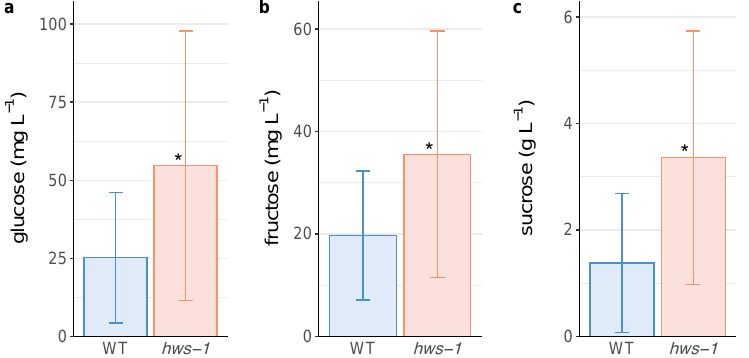
Figure 3. Phloem exudates from hws-1 contain more sugar than WT ones. Pedicels carrying 8 DAA to 20 DAA-old fruits were cut and phloem exudates were collected for seven of the dark hours in EDTA-HEPES. ( a ) Average glucose concentration in phloem sap exudates ( b ) Similarly to ( a ) for fructose ( c ) Similarly to ( a ) for sucrose. Bars represent mean values with standard deviation. Unpaired t -tests indicate significant differences (annotated with ∗ on the graphs) for all three sugars at the p < 0.05 level ( n = 26 and n = 15 for WT and hws-1 , resp.).